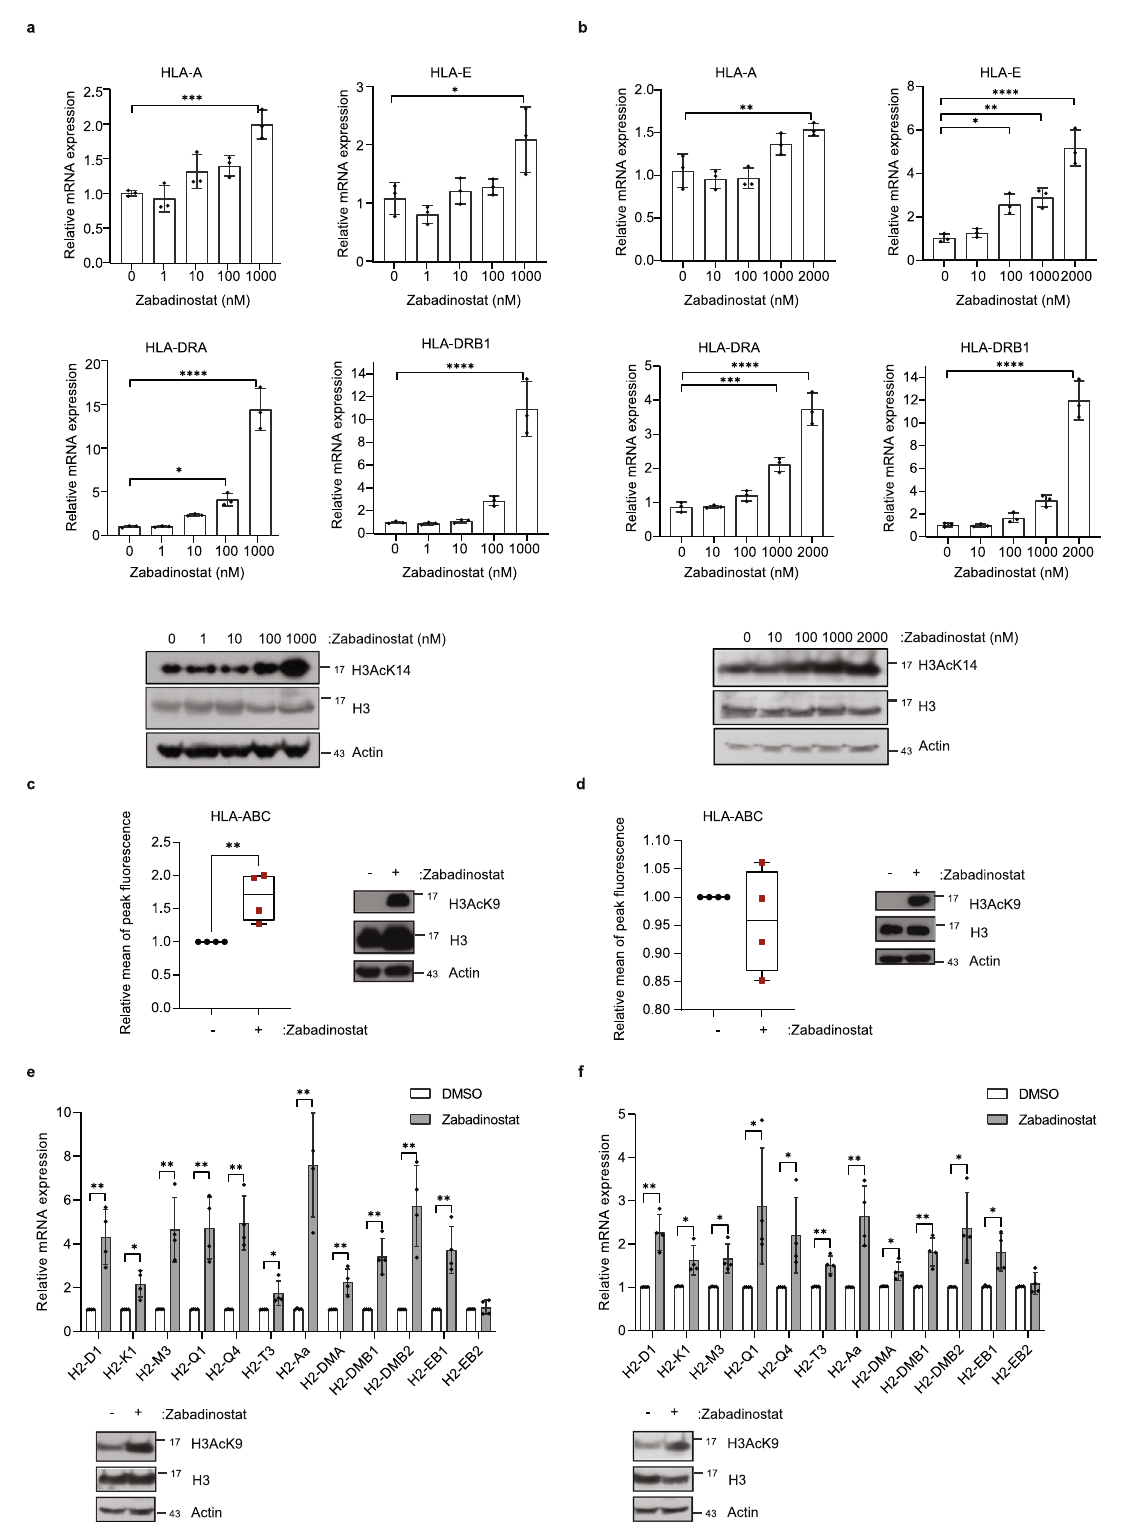
impact on the acetylation of histone (H) 3 lysine (K) 9 across the promoter region of MHC genes in BEAS2B cells, as H3K9 acetylation coincides with transcriptional activity (Fig. 2e, f) 1 . Zabadinostat treatment increased the level of the acetylation mark at H3K9 compared to the control untreated cells, without any signi fi cant change in the level of total H3 bound to the MHC gene promoters (Fig. 2f and Supplementary Fig. 5e). In conditions